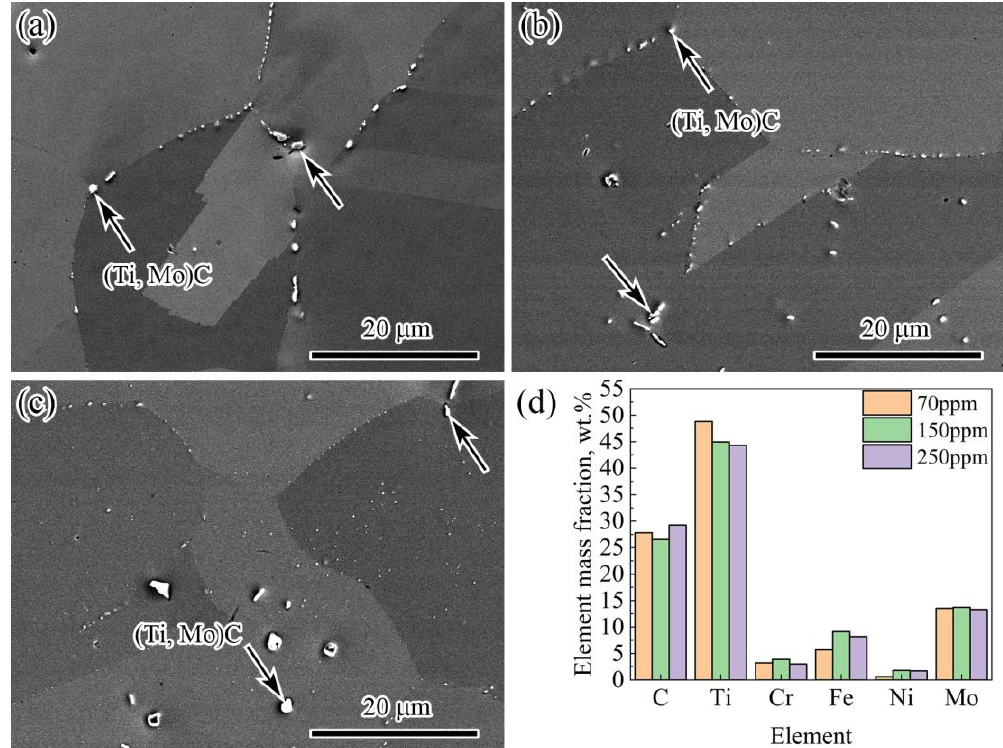
Figure 3. The SEM images of 15Cr–15Ni–Ti–xP alloy after being solution treated at 1120 ◦ C for 2 h: ( a ) 15Cr–15Ni–Ti–70P alloy, ( b ) 15Cr–15Ni–Ti–150P alloy, ( c ) 15Cr–15Ni–Ti–250P alloy and ( d ) SEM-EDS spectrum corresponding to MC